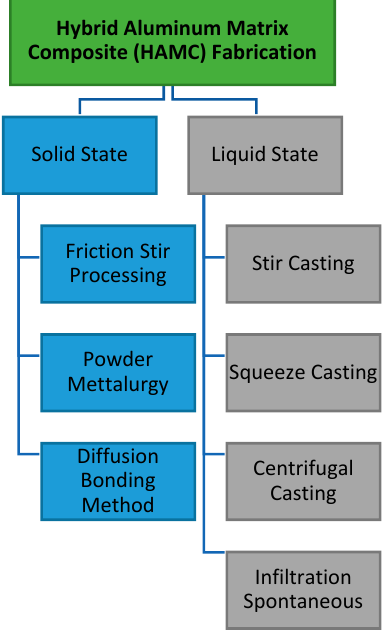
Figure 1. Fabrication process on the HAMC.